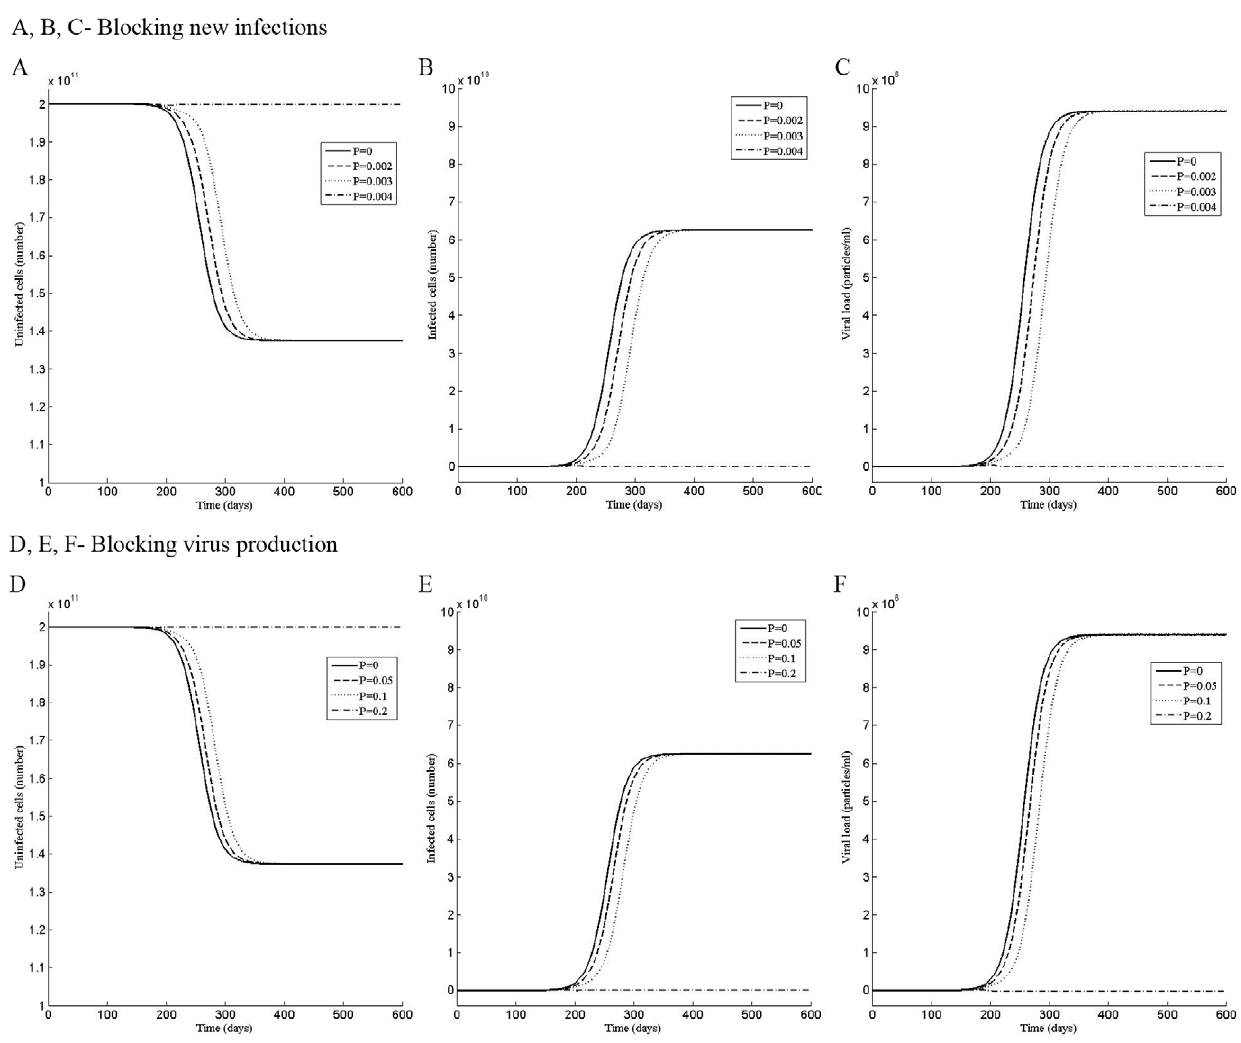
Figure 3. Perturbation in the second phase shows two steady states of the infection. Dynamics of the (A) uninfected cells, (B) infected cells, and (C) the viral load when the system was perturbed by the dose P of the drug that blocks new infections during the time period t=80 to t=260 day. Dynamics of the (D) uninfected cells, (E) infected cells, and (F) the viral load when the system was perturbed by the dose P of the drug that blocks virus production during the time period t=80 to t=260